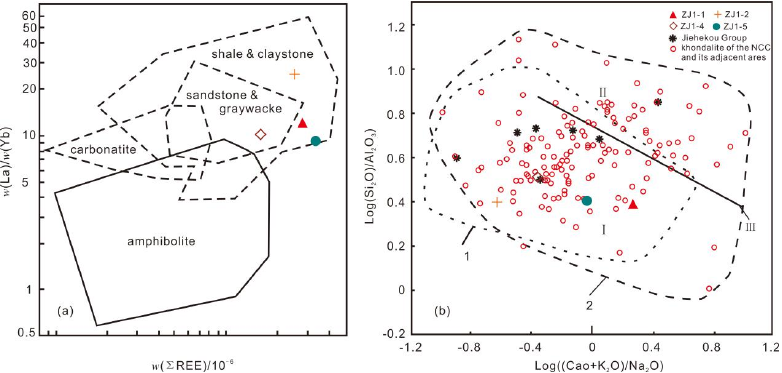
Figure 9. w Σ (REE)/10 − 6 − w(La)/w(Yb) and Log(CaO + Na 2 O)/K 2 O) − Log(SiO 2 /Al 2 O 3 ) plot for the basement rocks [68,72,80,81]. ( a ) showing the protolith of the paragneiss from the metamorphic basement should be argillaceous and arenaceous rock (after Bhatia, 1985). ( b ) showing the distribution of the different Khondalite series. 1- Distribution range of Khondalite series in southern India (after Dash et al., 1987); 2- distribution range of Khondalite series in the NCC and adjacent areas (after Wan et al., 2000). I - shale field; II - sandstone field; III - igneous trend (after Condie et al., 1992).